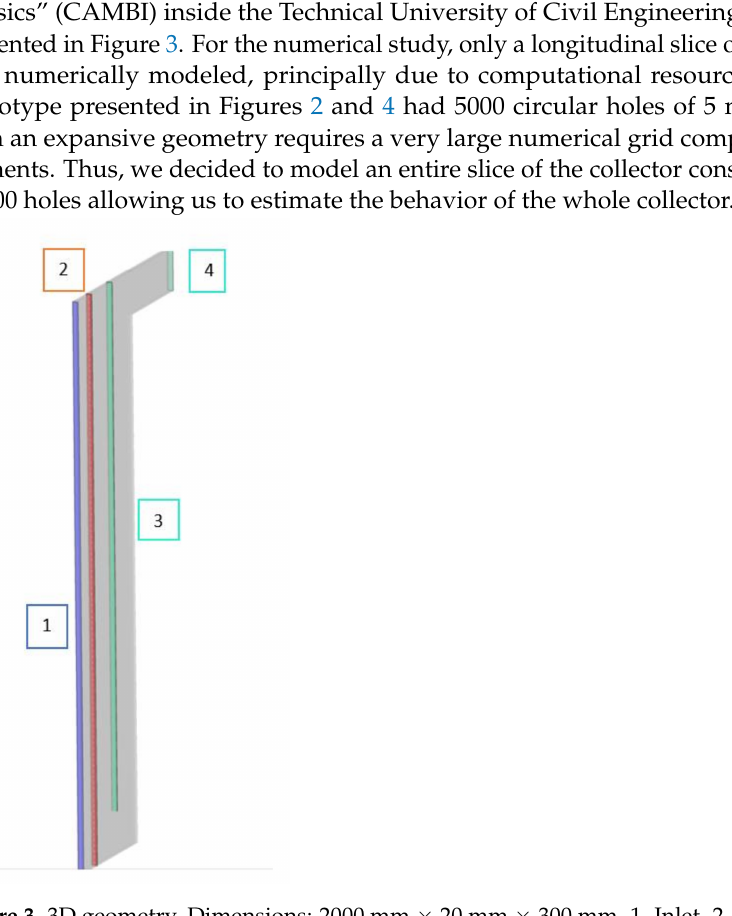
Figure 3. 3D geometry. Dimensions: 2000 mm × 20 mm × 300 mm. 1. Inlet. 2. Perforated absorber plate. 3. Second plate. 4. Outlet.